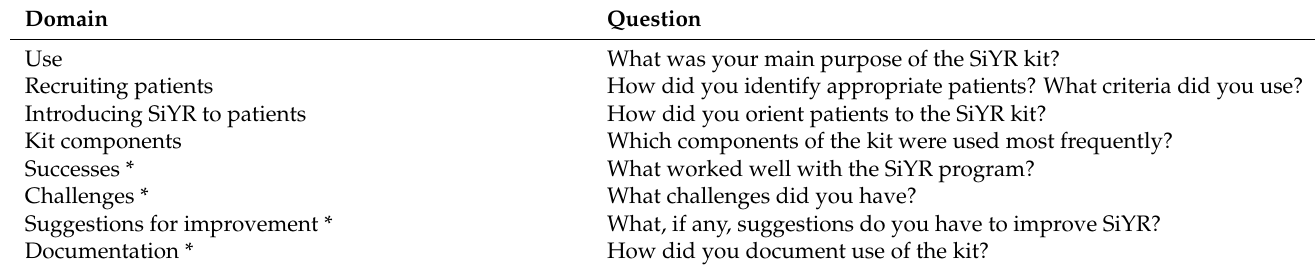
Table 2. Feedback requested from sites during pilot